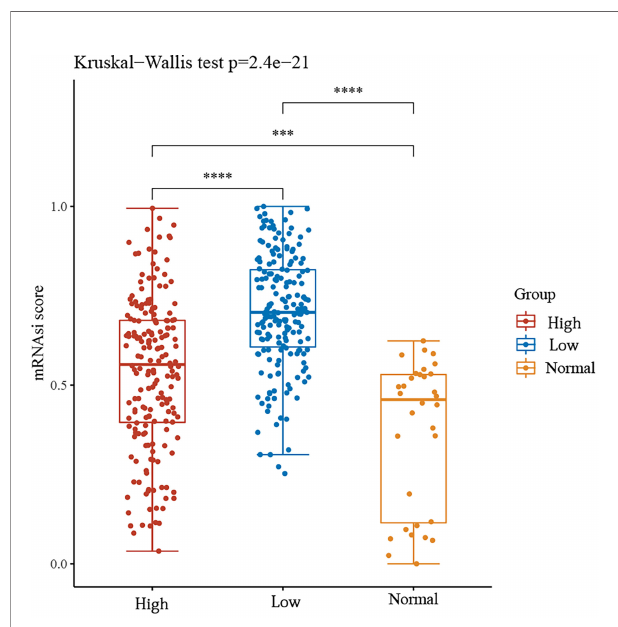
FIGURE 5 | mRNAsi scores between high and low GSDME expression groups and normal groups. ***P < 0.001, ****P <